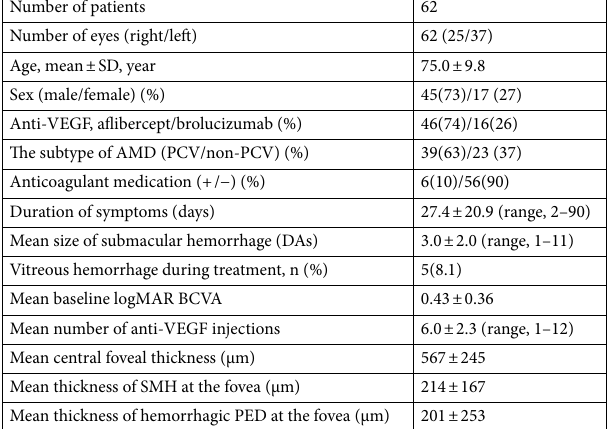
VH + group (n = 5) VH − group (n = 57) P